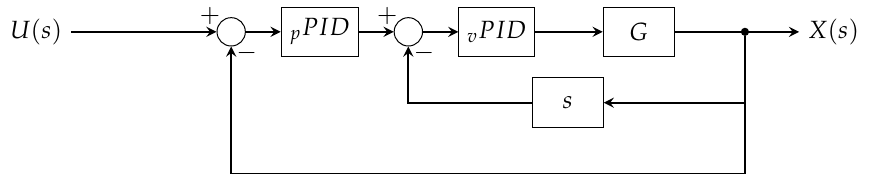
Figure 2. Structure of the control loop for the electric